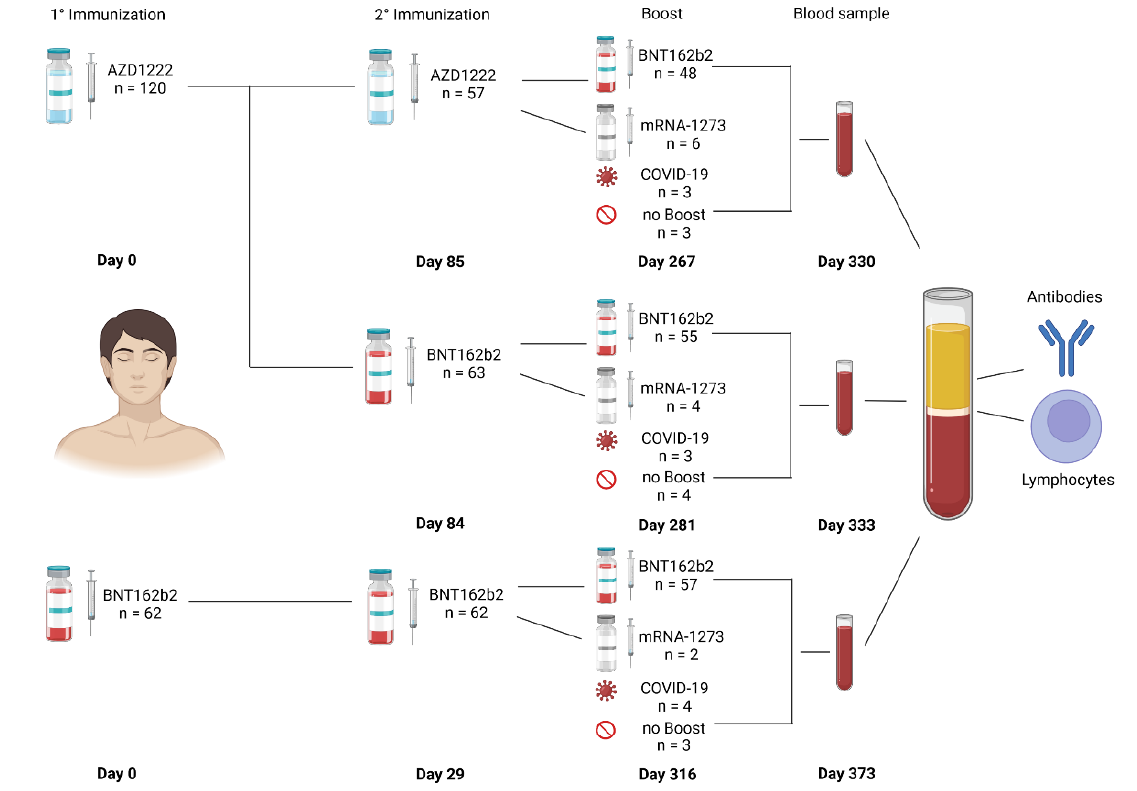
Figure 1. Vaccination regimens were grouped according to the respective prime/boost. Homologous and heterologous prime/boost regimen with either AZD1222/AZD1222, AZD1222/BNT162b2, or BNT162b2/BNT162b2 led to the recruitment of 182 study participants. Mean time intervals between immunizations (days) and vaccines (AZD1222 = ChAdOx1 from AstraZeneca, BNT = BNT162b2 from Pfizer/Biontech, mRNA-1273 from Moderna) are given.